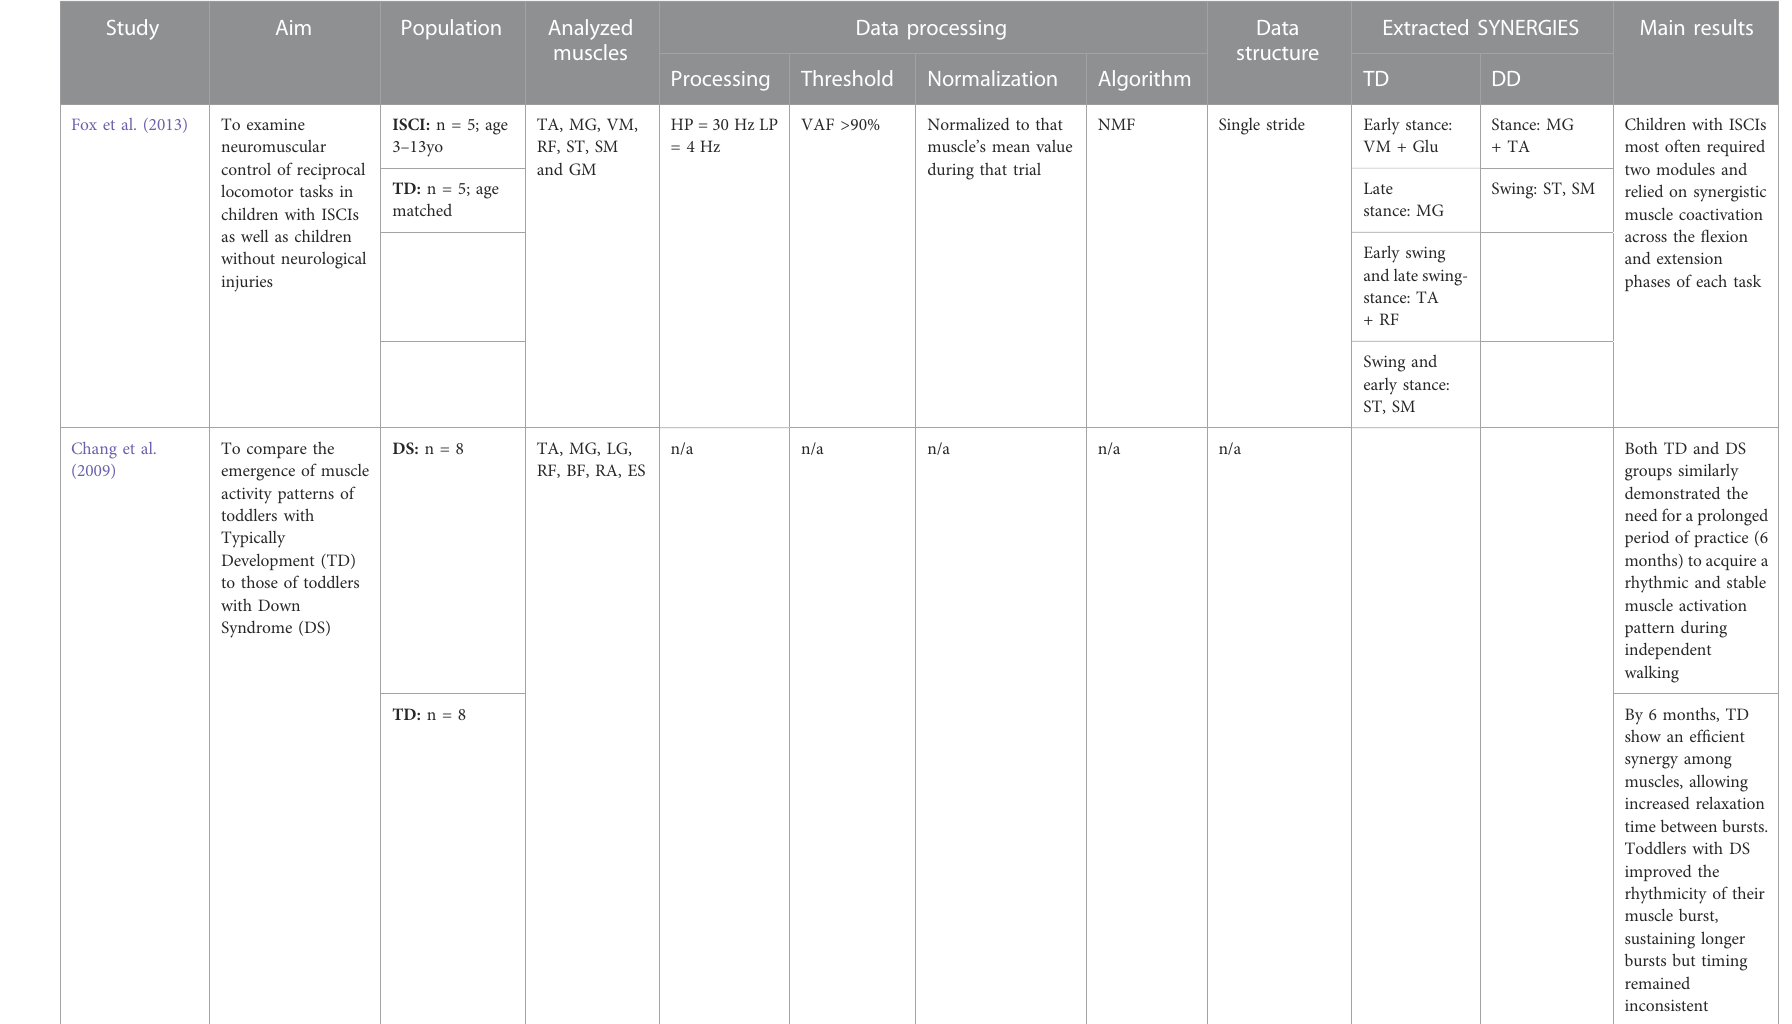
TABLE 3 ( Continued ) Aim of the study, population, analyzed muscles, data processing, data structure, extracted synergies, main results of the articles investigating how muscle synergies vary in children affected by other developmental diseases in respect to healthy controls. Acronyms: DMD: Duchenne muscular dystrophy, CP: cerebral palsy, PWHA: people with hemophilic arthropathy, ISCI: Incomplete Spinal Cord Injury, ID: